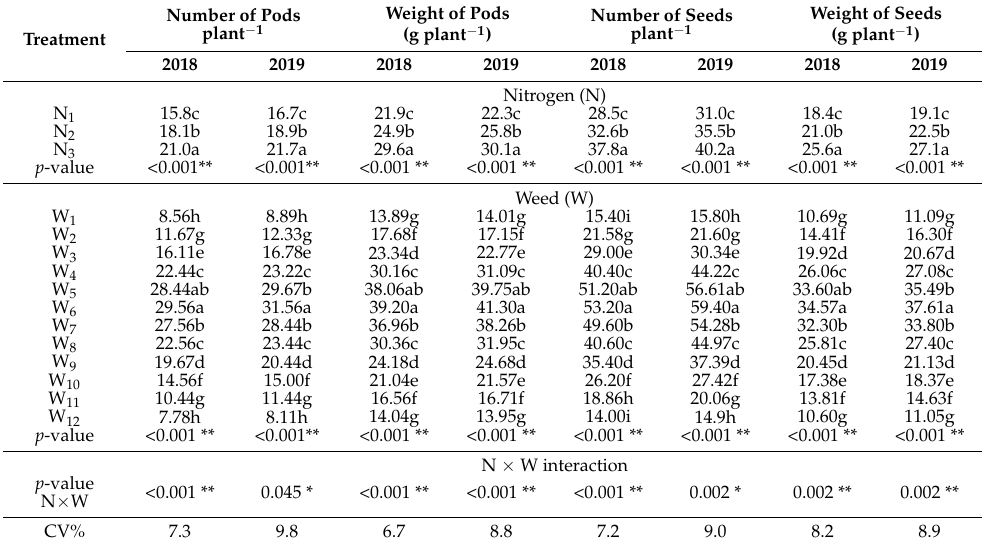
*, ** refer to the significant variation at ( p ≤ 0.05) and ( p ≤ 0.01), respectively, and “ns” point to non-significant variation. Means sharing the same letter in each column are not significantly different at p ≤ 0.05 by Duncan’s